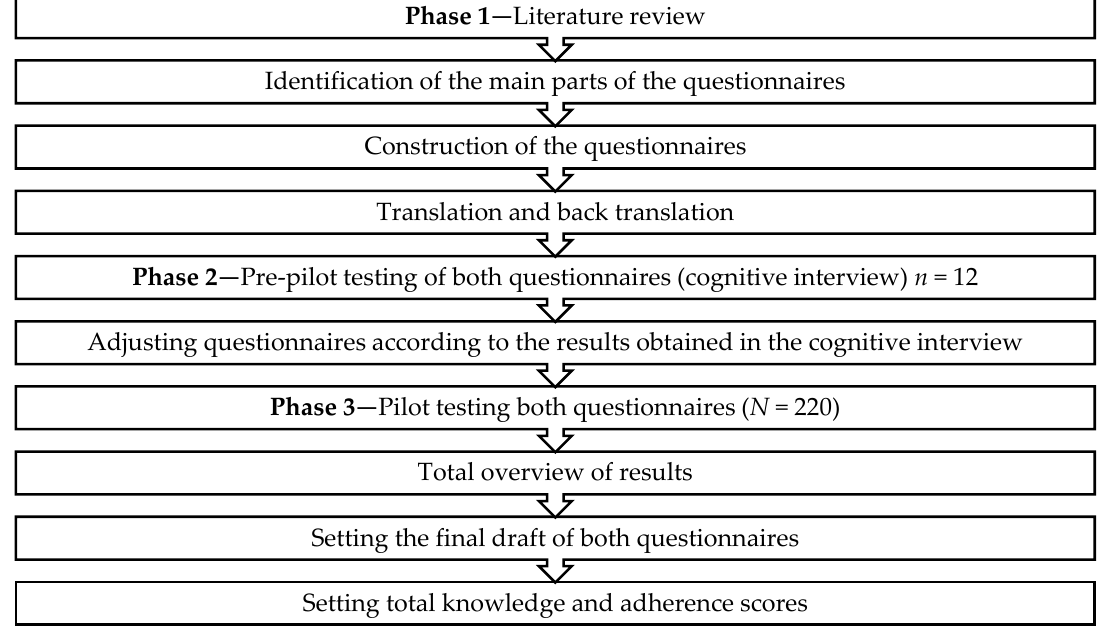
Figure 1. Development phases of dietary knowledge and adherence questionnaires.